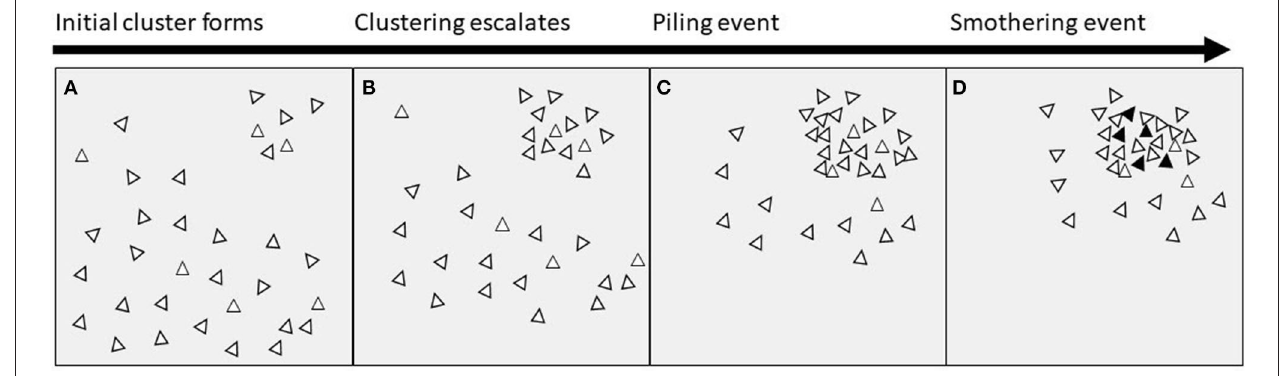
FIGURE 1 | Proximate timeline of events leading to smothering. (A) An initial cluster of birds is formed by attraction to/repulsion from a stimulus or location, or by chance, or by timing factors; (B) the clustering behavior escalates due to social attraction, or attraction to/repulsion from the original stimulus or location; (C) a dense pile of birds is formed; (D) the pile exceeds an unknown threshold and ends in a smother, with mortality of birds indicated by black